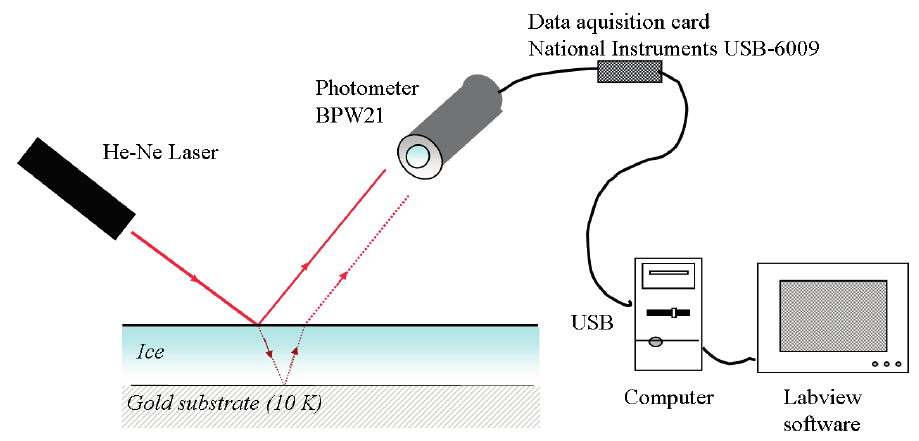
Figure 6. Scheme for thickness measurement using a single laser.